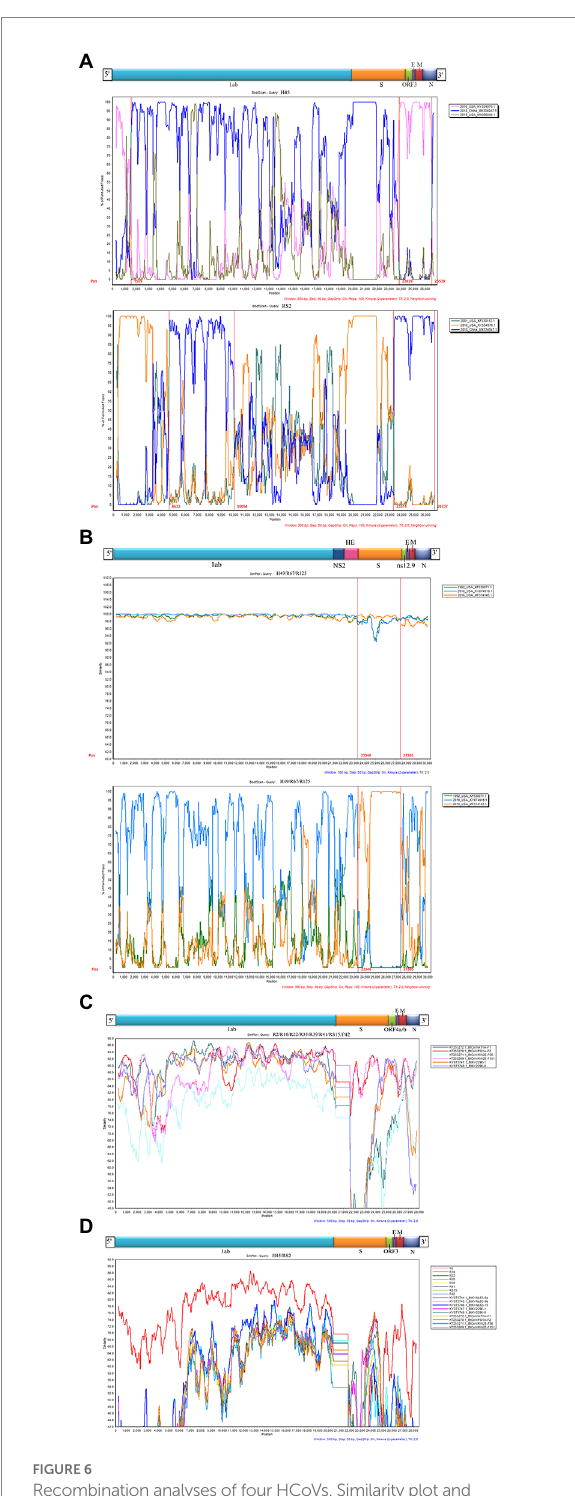
FIGURE 6 Recombination analyses of four HCoVs. Similarity plot and bootscan analysis were performed intraspecies ( A : HCoV-NL63 and B : HCoV-OC43) and interspecies ( C : HCoV-229E and BtKY229E; D : HCoV-NL63, HCoV-229E, BtKY229E and BtKYNL63).